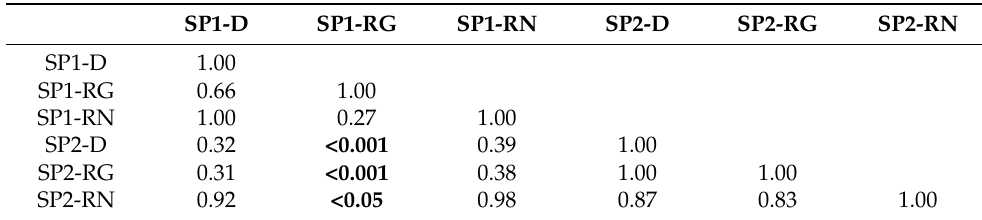
Table 3. p -values for Tukey multicomparison tests of the ANCOVA analysis standard distance~SP- ovarian development phases in the last 15 days before capture in European hake females. Significant p -values are shown in boldface type.